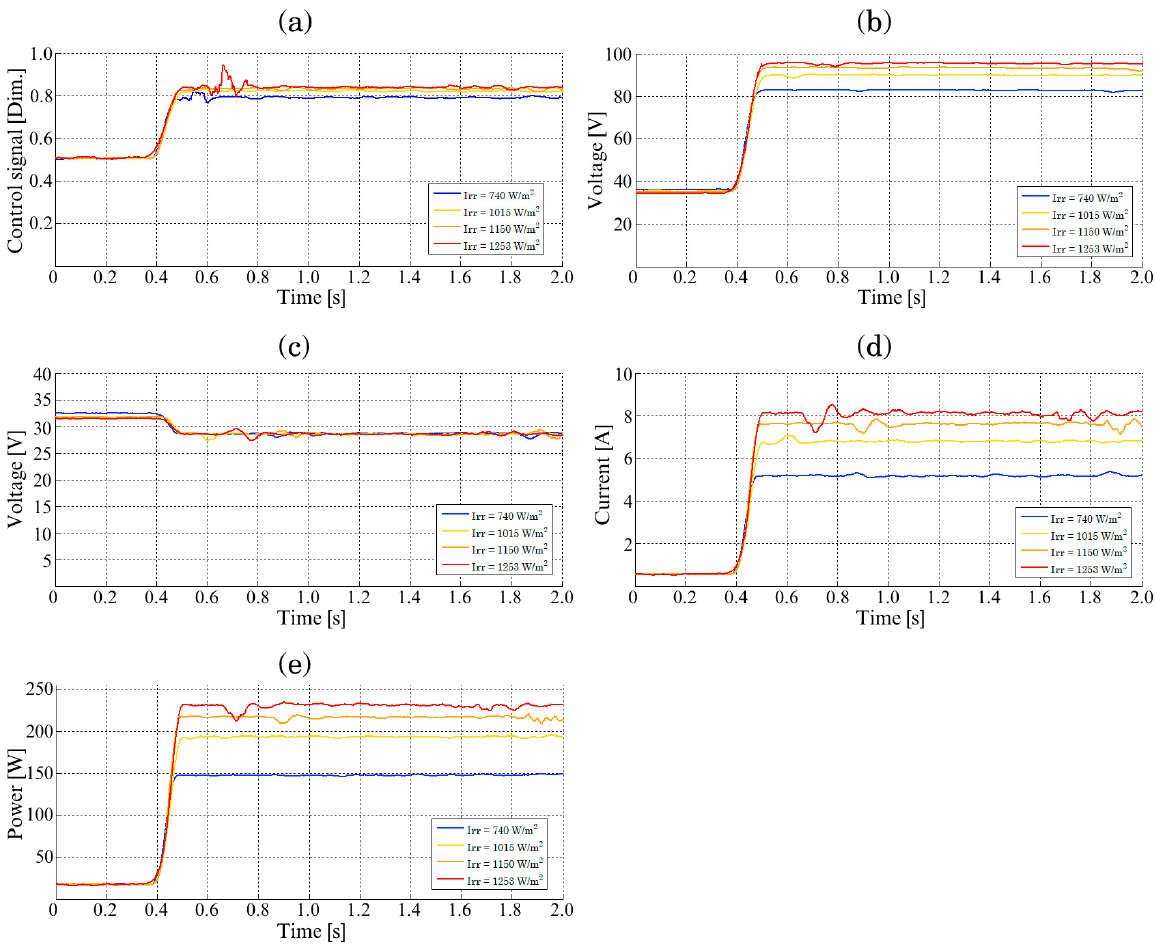
Figure 19. MPP tracking: ( a ) P&O algorithm signal control, ( b ) DC bus voltage, ( c ) PV cells voltage, ( d ) PV cells current, and ( e ) PV cells power.